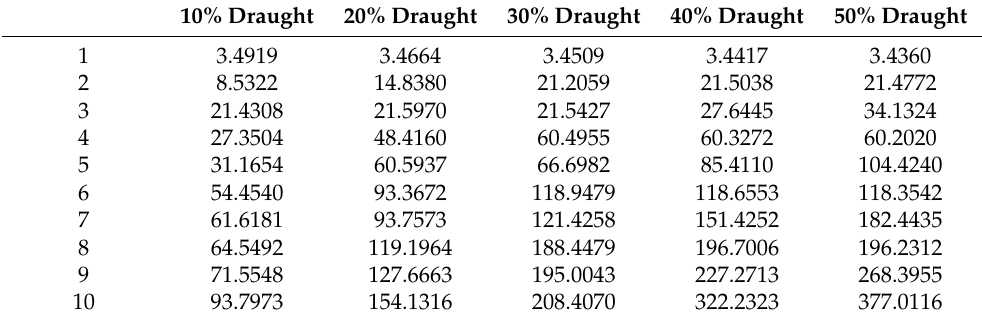
Table 2. Numerical values of natural frequencies of the system for various draught ratios.